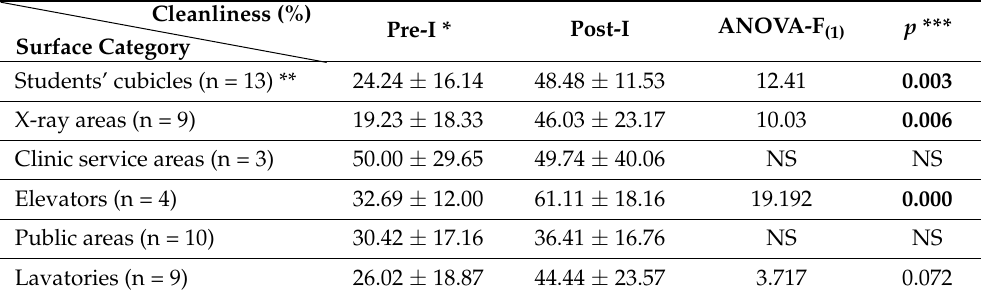
Table 1. The percentage of clean surfaces at pre- and post-intervention evaluations (pre-I versus post-I).